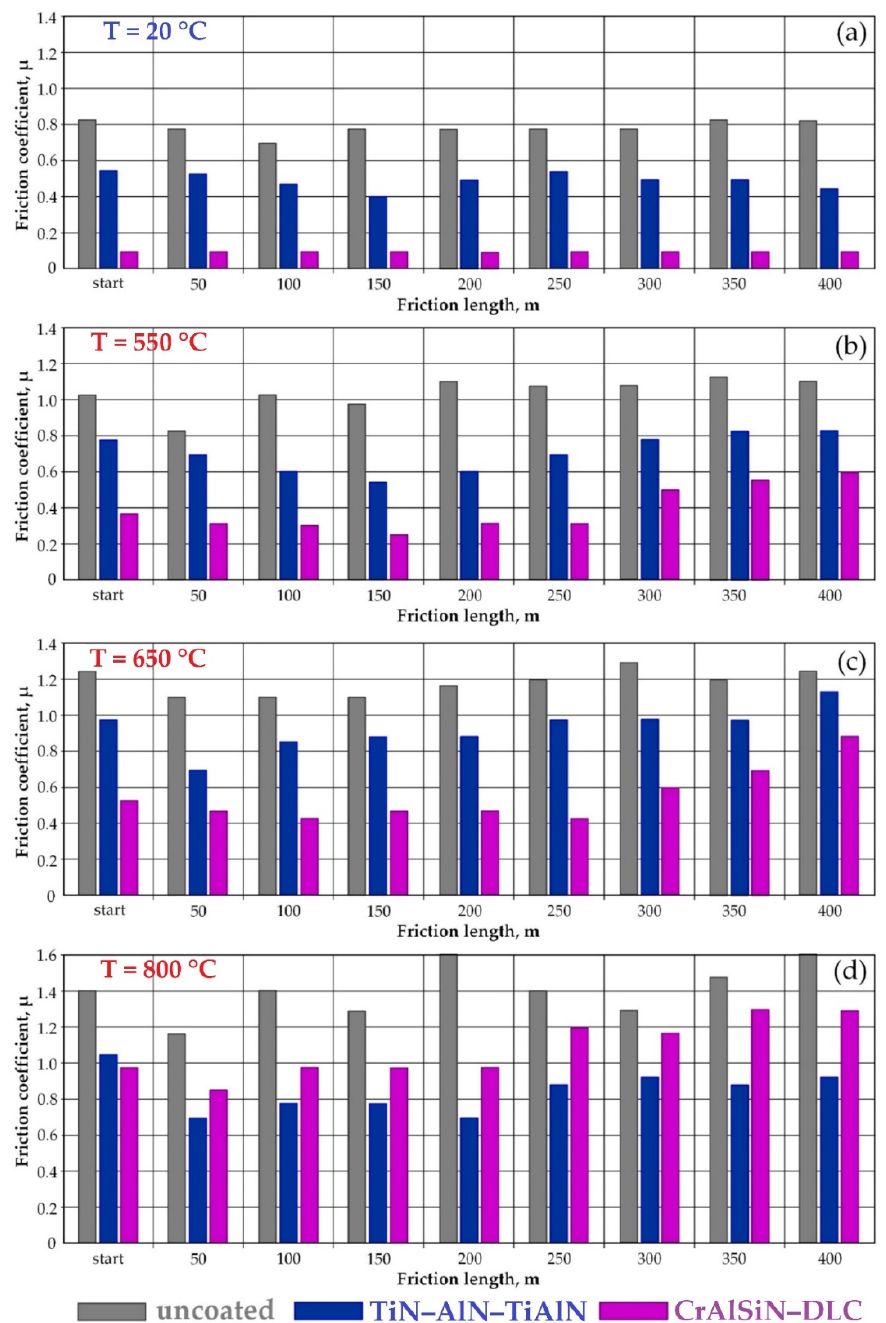
Figure 7. Dependences of the friction coefficient of the surface of hard-alloy specimens with differ- ent coatings on the length of the friction path with varying temperature test conditions: ( a ) 20 °C; ( b ) 550 °C; ( c ) 650 °C; ( d ) 800 °C.